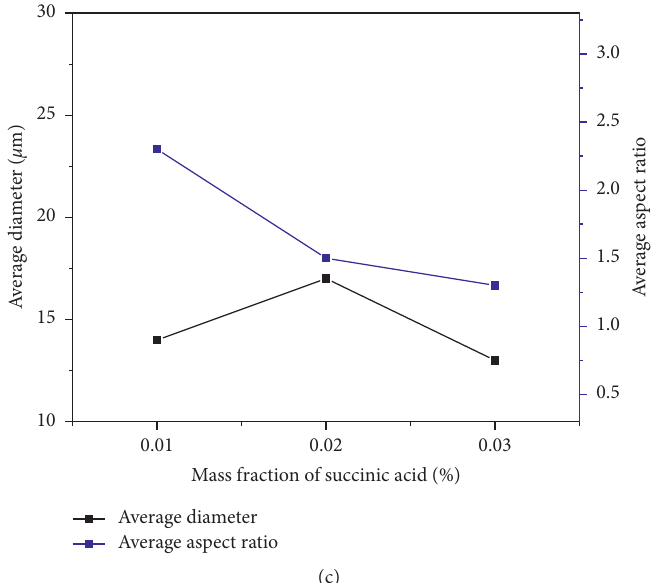
Figure 11: Solid-phase crystallization water content (a), solid-phase XRD pattern (b), and crystal size (c) of succinic acid (doped with 0.01%, 0.02%, and 0.03%) for 1.5h.